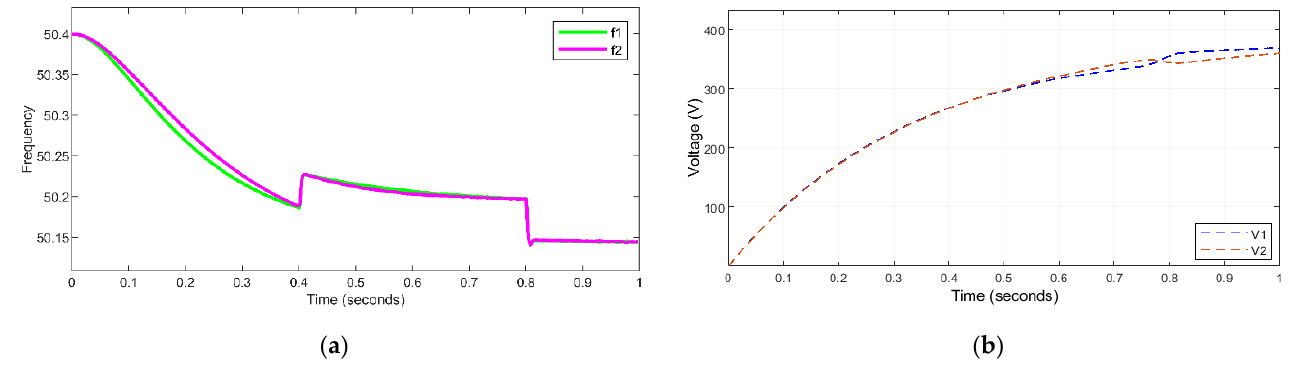
Figure 7. Generating uncertain parameters: ( a ) frequency; ( b ) voltage.